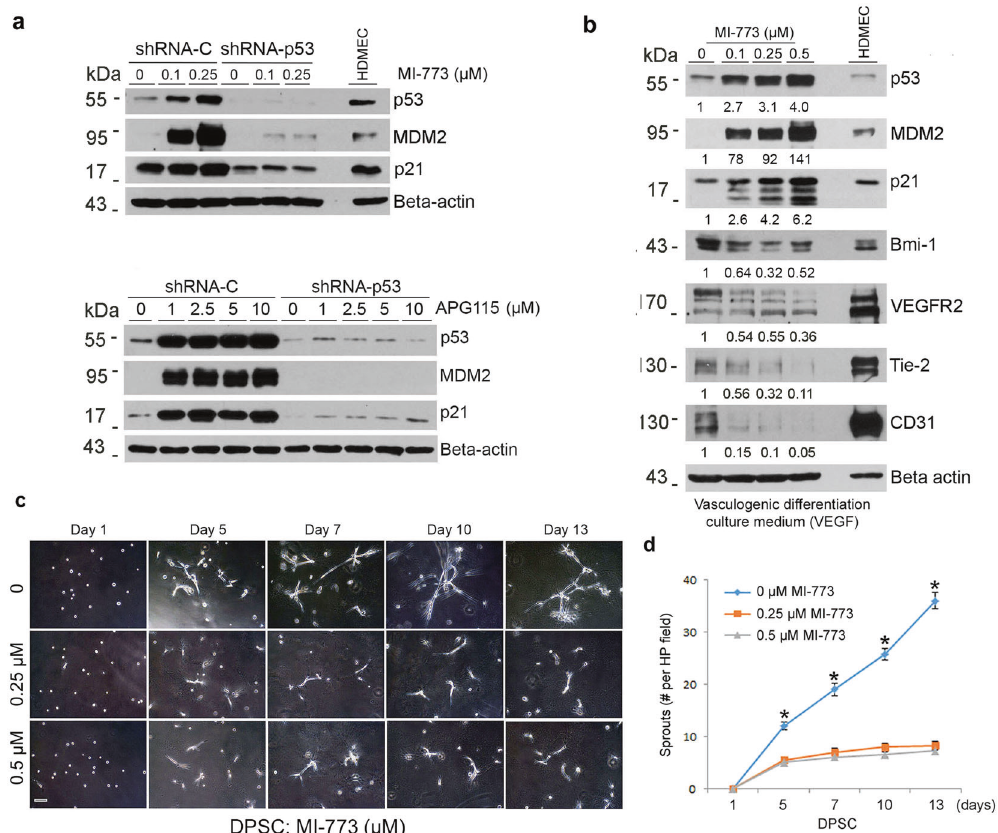
Fig. 3 Stabilization of p53 by blockade of the p53-MDM2 binding inhibits vasculogenic differentiation of dental pulp stem cells. a shRNA- p53 transduced DPSC were treated with 0 – 2.5 µM MI-773 and 0 – 10 µM APG-115 for 24 h, western blots were performed for P53, MDM2, and p21, β -actin was used as loading control. b DPSC were cultured with endothelial differentiation medium in the presence of 50 ng/ml VEGF and 0 – 0.25 µM MI-773 for 14 days, western blots for p53, MDM2, p21, Bmi-1, VEGFR2, Tie-2, and CD31. The density of protein expression was normalized with β -actin. c , d 1 × 10 4 DPSC were seeded in growth factor-reduced matrigel and cultured in endothelial differentiation medium (EGM2) in the presence of 0 – 0.5 µM MI-773 for 13 days. c photographs of sprout, scale bar:100 µm. d Graph depicting the number of sprouts formed in c . Asterisk indicates p < 0.001, as determined by one-way ANOVA followed by a post hoc test (Tukey ’ s